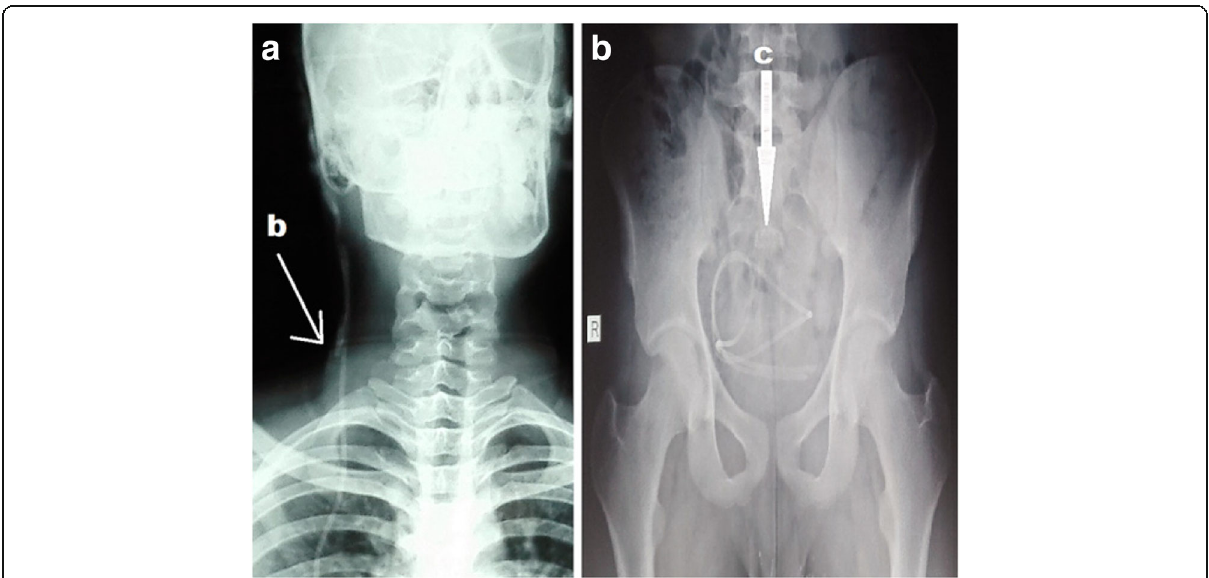
Fig. 8 a Plain X-ray AP view on the skull and upper chest of a 17-year-male patient showing a fracture of distal tube of right VP shunt at the neck region (b arrow). b Plain X-rays AP view on the pelvis migrated disconnected distal catheter (c arrow)